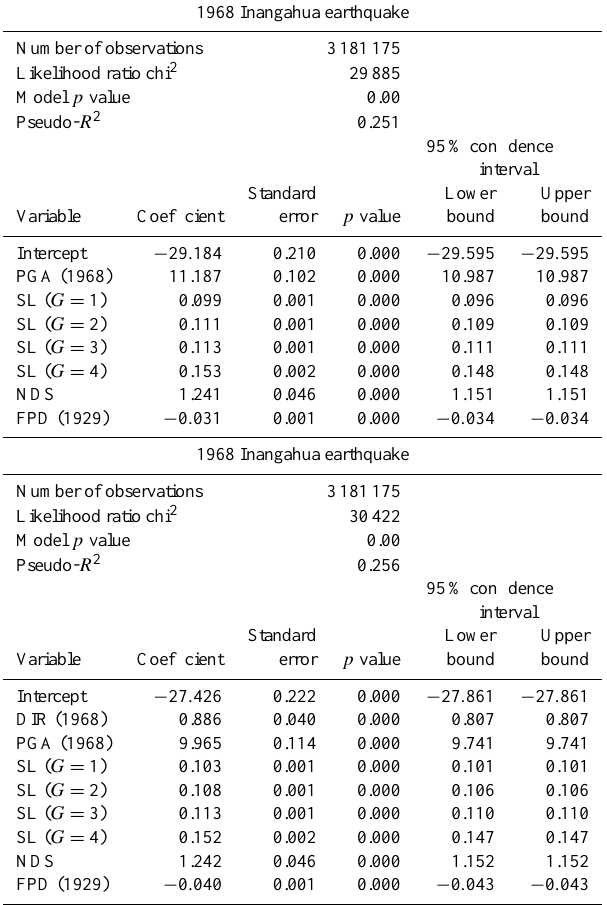
Table 5. Logistic regression output coefficients and fit statistics, for models including the influence of the 1929 earthquake on the 1968 landslide